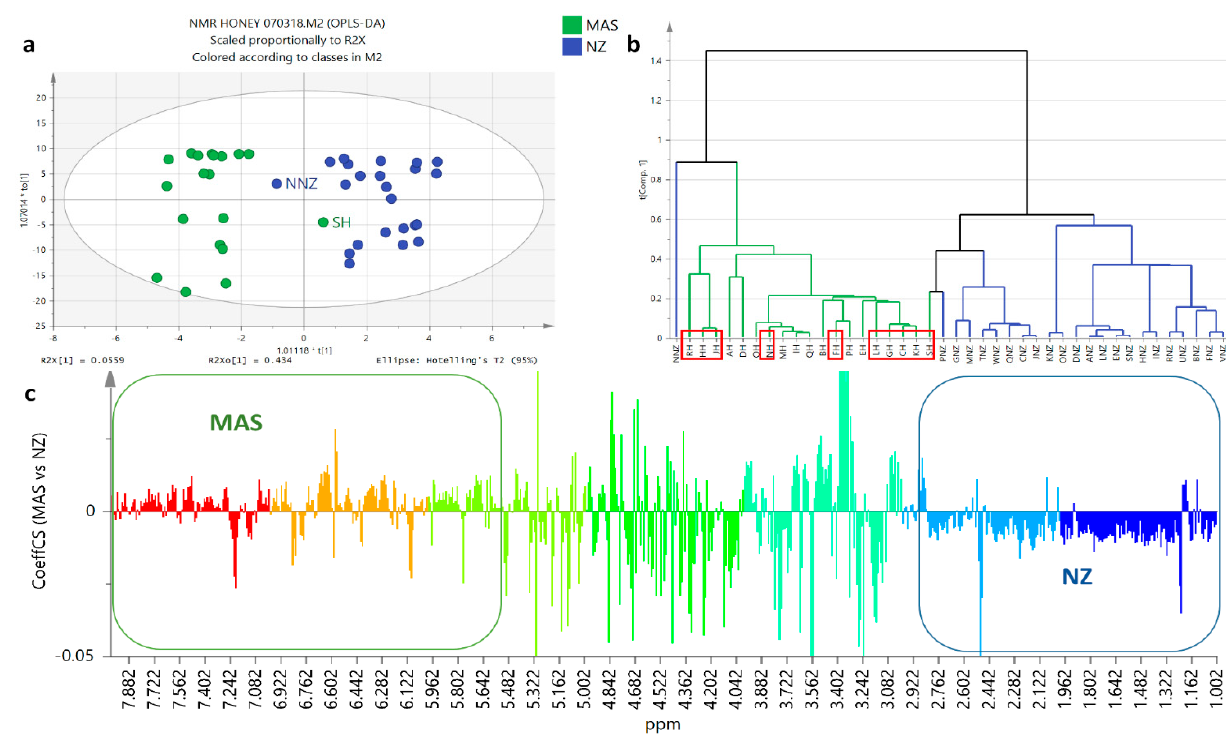
Figure 5. OPLS model employing the NMR spectral dataset. Bioactive extracts were boxed in red. ( a ) OPLS-DA scores plot (R 2 = 0.84 and Q 2 = 0.59). Permutation test generated a Q 2 Y = − 0.682. ( b ) HCA by single linkage, and ( c ) coefficient plot of 1 H NMR spectral data of honey extracts. Legend: MAS (Malaysian samples), NZ (New Zealand samples).